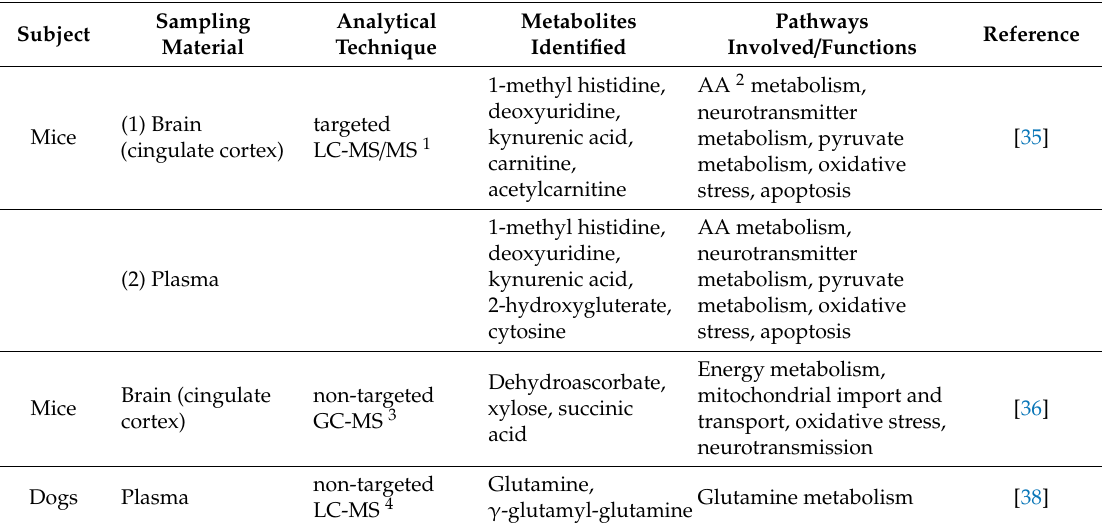
Table 2. Possible biomarkers identified in animal-based studies of